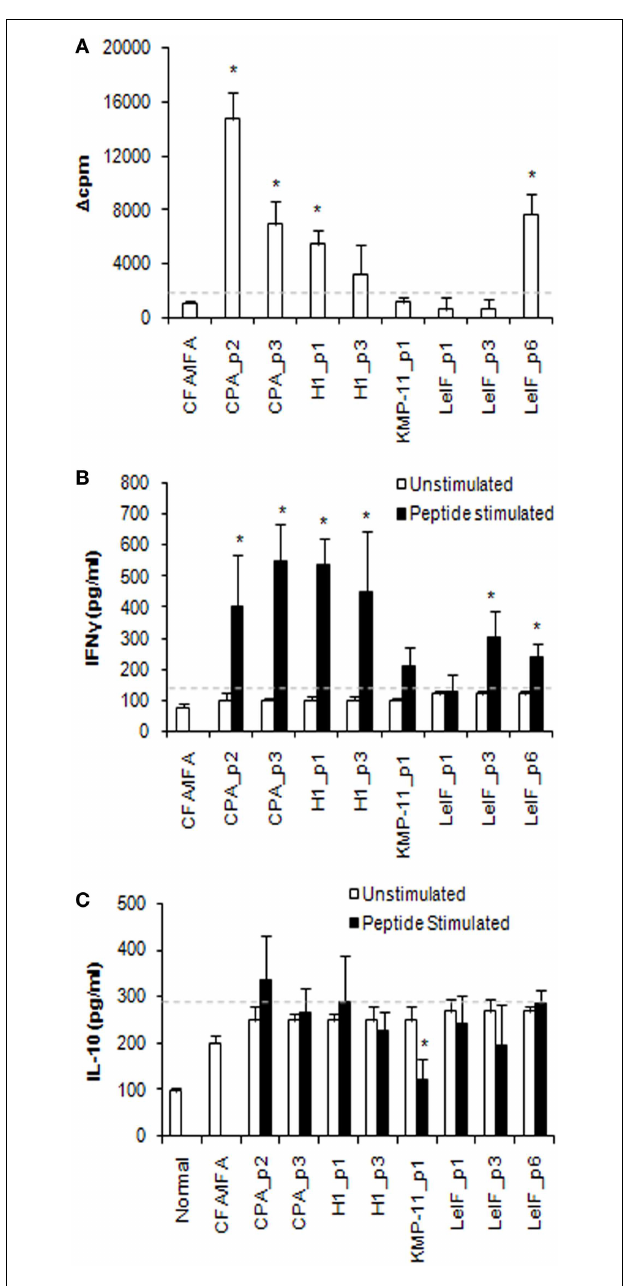
FIGURE 1 | Multi-epitope peptide-specific proliferative responses and cytokine secretion . (A) Proliferative responses. Spleen cells from BALB/c mice ( n = 3/group) immunized either with individual peptide emulsified in CFA/IFA or PBS alone, were re-stimulated in vitro with the respective peptide (10 µ g/ml) for 72h. Cultures were pulsed for the final 18h with 1 µ Ci of [ 3 H]-TdR and results are depicted as ∆ cpm ± SD as described in Section “Materials and Methods.” Spleen cells derived from mice immunized with PBS alone, stimulated in vitro with ConA ( ∆ cpm: 39743 ± 843) were used for comparison purposes. (B) IFN- γ and (C) IL-10 secretion. Cytokines were detected in culture supernatants of spleen cells from immunized BALB/c mice ( n = 5/group), re-stimulated in vitro with the respective peptide (10 µ g/ml) for 72h, by ELISA.The results are expressed as pg/ml ± SD. Significant differences between groups of mice immunized with each synthetic peptide emulsified in CFA/IFA and the group of mice immunized with CFA/IFA alone are indicated by * ( P <